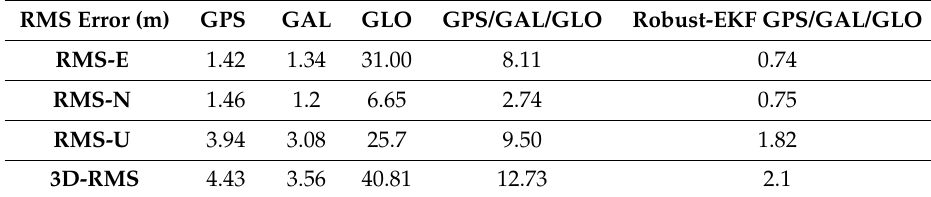
Table 2. RMS Errors in Position for the five scenarios at station ABMF in 24 h.